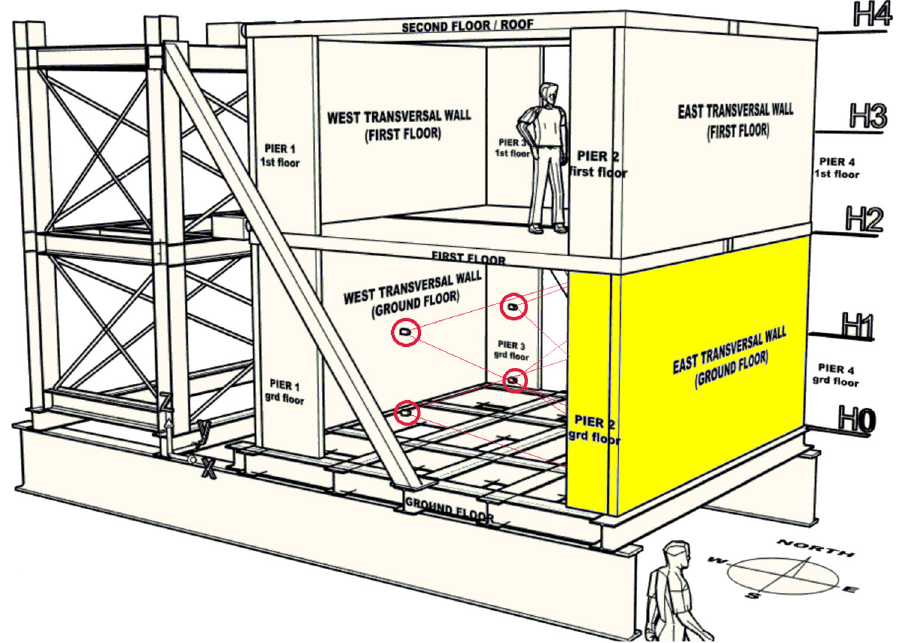
Figure 1. Schematic representation of the photogrammetric set-up used to monitor the out-of-plane deformations of the east transversal wall on ground floor (part highlighted in yellow). Red circles indicate the four Basler cameras used to obtain the three-dimensional (3D) photogrammetric network. The cameras were fixed on an isolated and stable steel frame inside the house, ensuring that the photogrammetric network remained stable during the experimental test. The positive loading direction went from west to east.